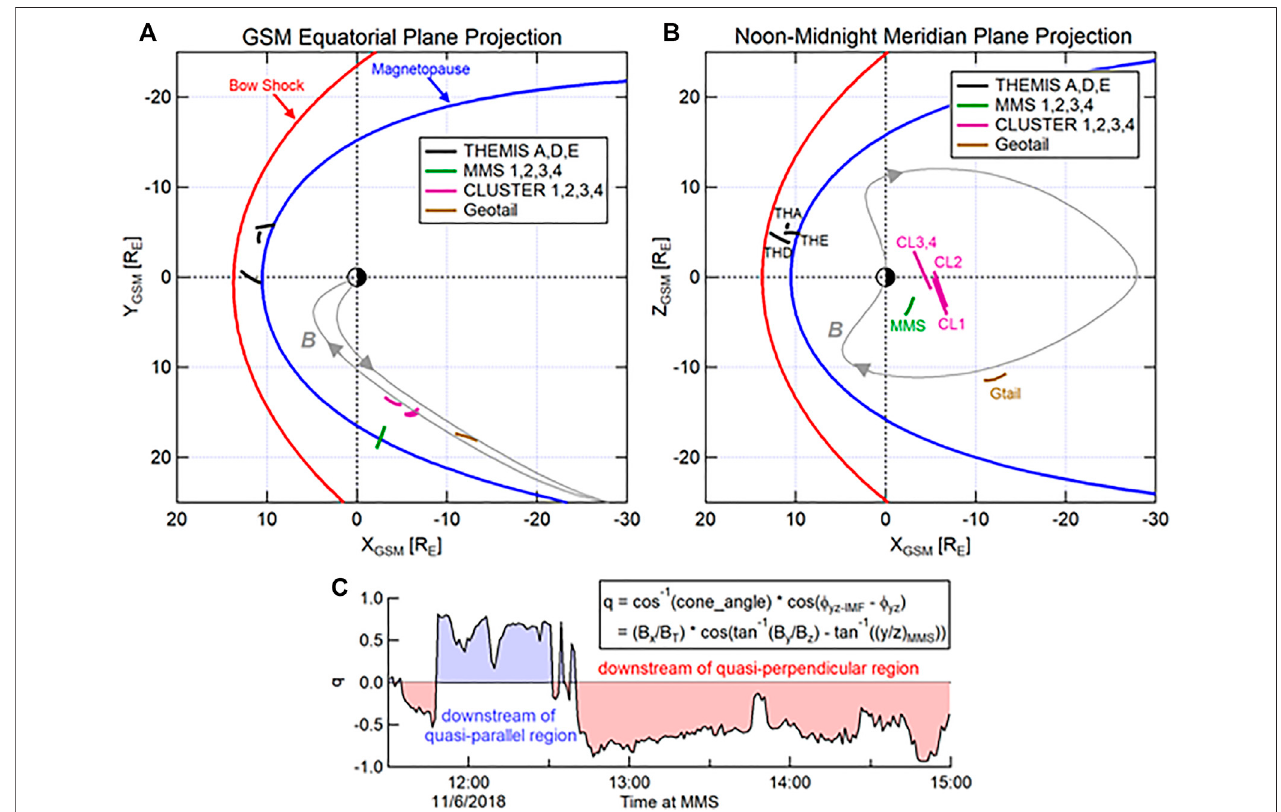
FIGURE 2 | Spacecraft locations in GSM coordinates during the interval 2018-11-06, 11:30 – 15:00 UT. (A) Equatorial plane projection; (B) Meridian plane projection.Theredtracedemarkstheparameterizedbowshockshapeandlocation;whilethebluetracedemarkstheparameterizedmagnetopauseshapeandlocation. A magnetospheric magnetic fi eld line (grey) is traced from the center location of the ionospheric bead in the northern ionosphere into the magnetotail and ending in the southern ionosphere. (C) Time series of parameter “ q ” . This parameter uses the ARTEMIS 1 IMF components (convected to the bow shock, plus an additional convectiontimeof7 mins)inconjunctionwiththeMMSY/ZlocationtodeterminewhethertheregionlocaltoMMSwasdownstreamofthequasi-parallelbowshock( q > 0, in blue), or was downstream of the quasi-perpendicular bow shock ( q < 0, in